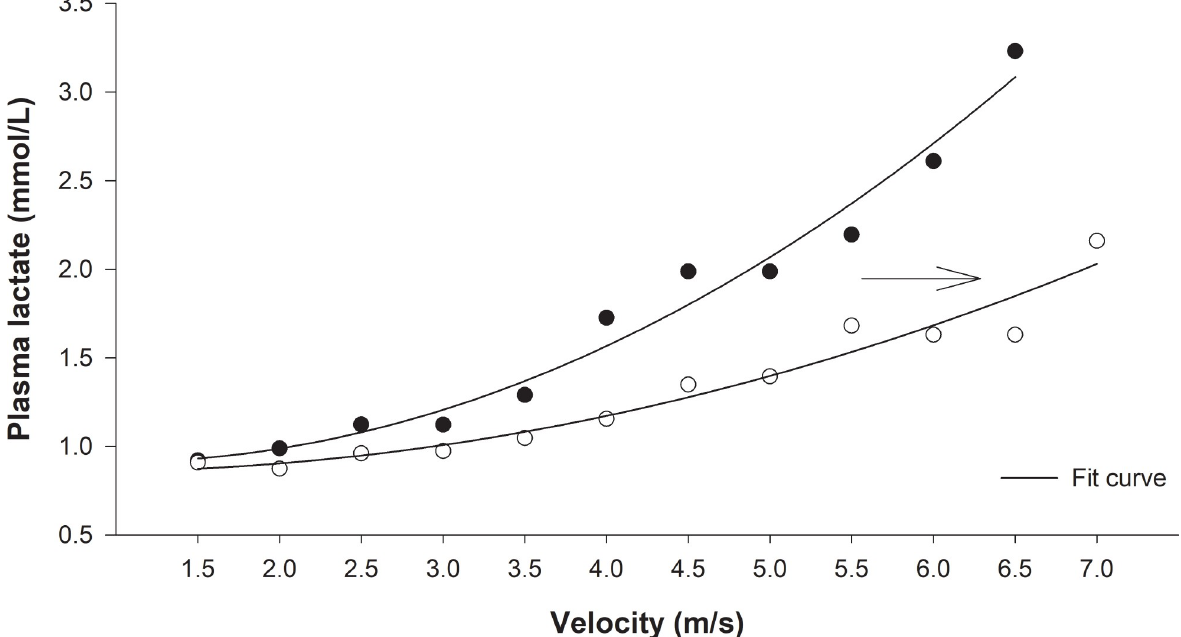
Fig 2. Lactate velocity curves (LVC) of Beagle dogs subjected to incremental exercise tests (IETs). LVC IET-1 and IET-2, after eight-week endurance-training program (Trained Group). Note the exponential tendency lines. IET-1: Y = 0.1341 .0706x , P < . .0001, R = 0.98; IET-2: Y = 0.0477 .0303x , P < .0001, R = 0.97. Black and white dots are means and correspond to the values obtained at IET-1 (before training) and IET-2 (after training),